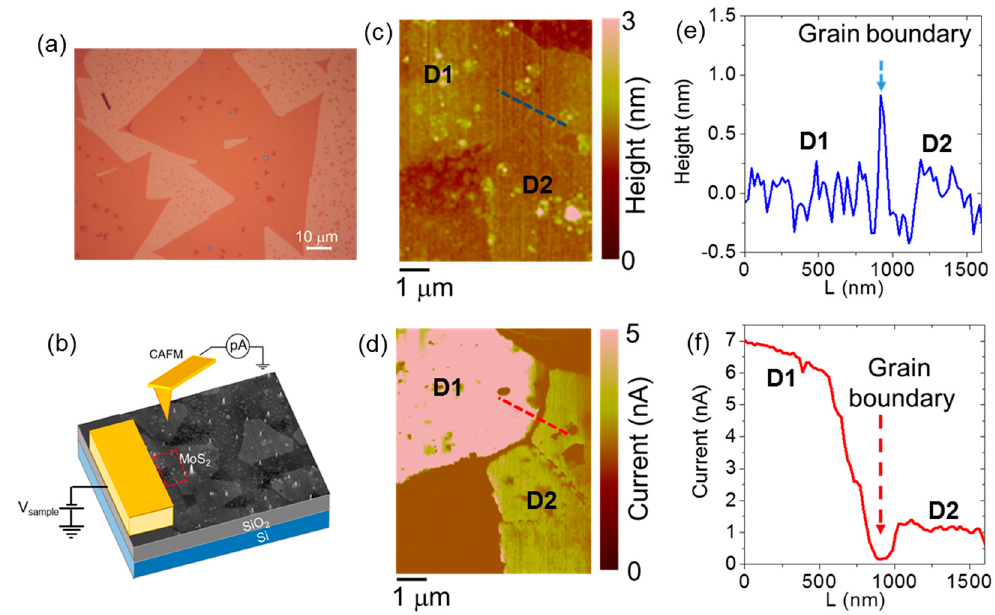
Figure 8. ( a ) Optical microscopy of CVD-grown monolayer MoS 2 domains on a SiO 2 / Si substrate. ( b ) Illustration of the experimental setup for the local current measurement on MoS 2 domains by C-AFM. ( c ) Morphology and ( d ) current map measured by C-AFM on a region with two MoS 2 domains (D1 and D2) separated by a grain boundary. The domain D1 is directly connected to the macroscopic contact. ( e ) Height and ( f ) current line-scans across the grain boundary. Images adapted with permission from Reference [85], copyright from Wiley 2020.